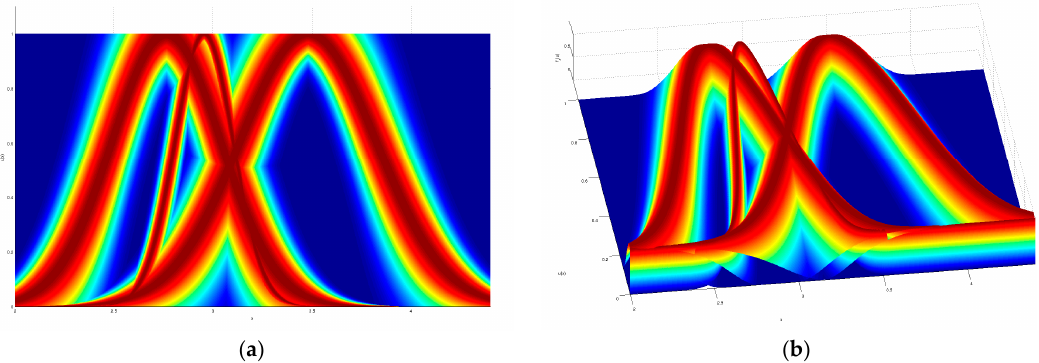
Figure 8. Input partition of the GT2 TSK FLS for the second input of the iris dataset, where ( a ) shows a top view of the GT2 membership functions; and ( b ) shows an orthogonal view of the same GT2 membership functions.